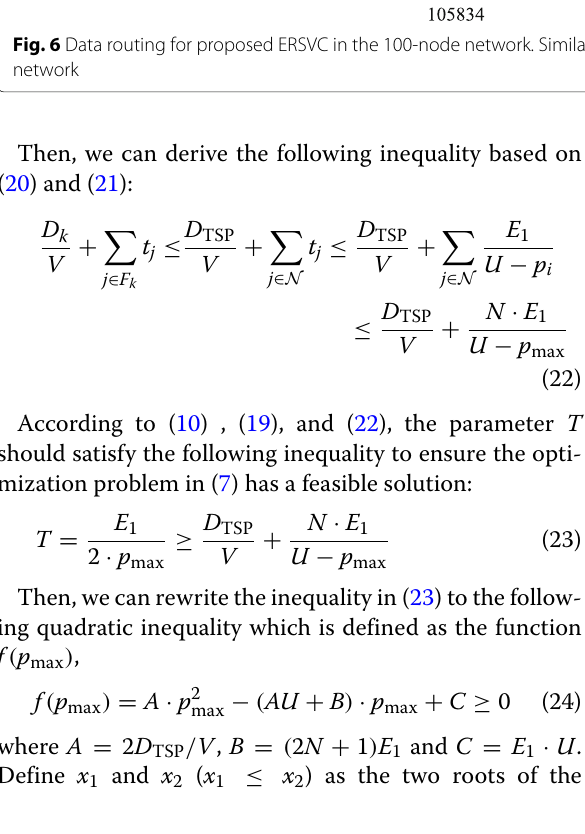
Table 6 The result of the classified set S k ( k = 1, 2, . . . , r ) for the 100-node network